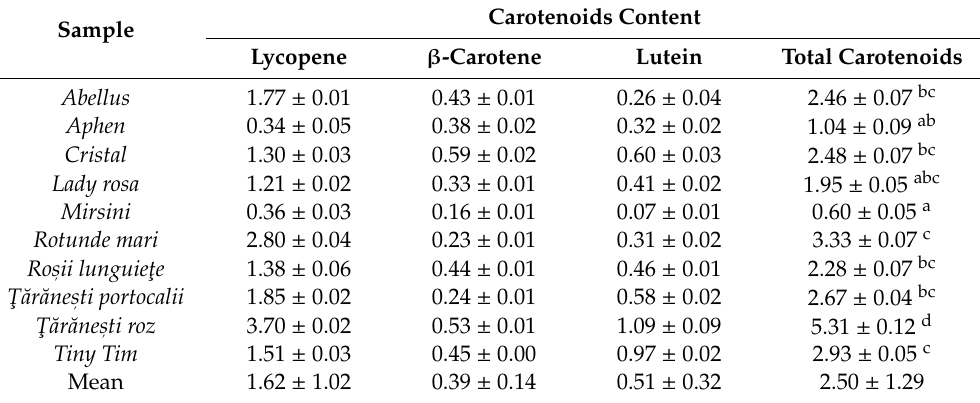
Table 1. Content of individual carotenoids of ten tomato varieties peels extracts (mg / 100 g DW) ± SD.